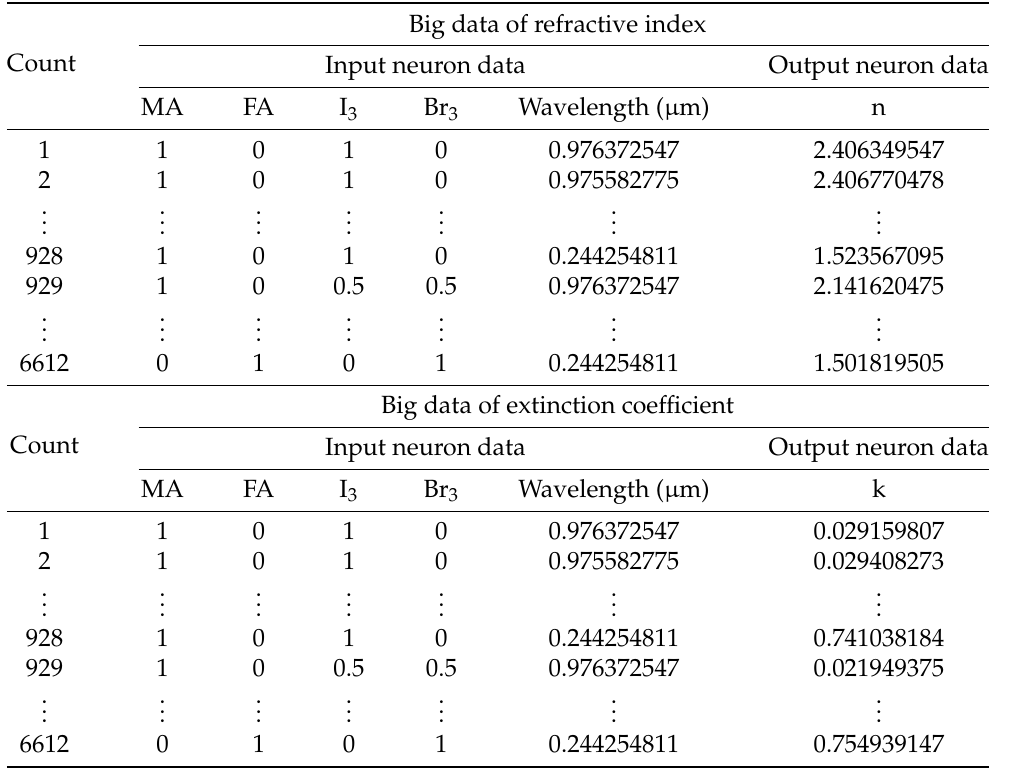
Table 2. Big data of refractive index and extinction coefficient composition details according to the optical properties of perovskite materials by stoichiometric